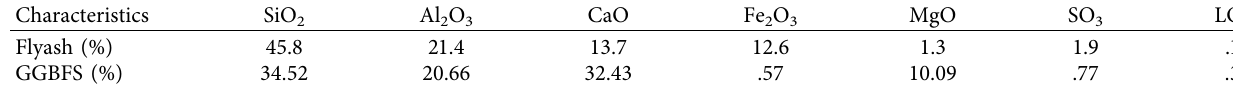
Table 1: Composition of fly ash and GGBFS.